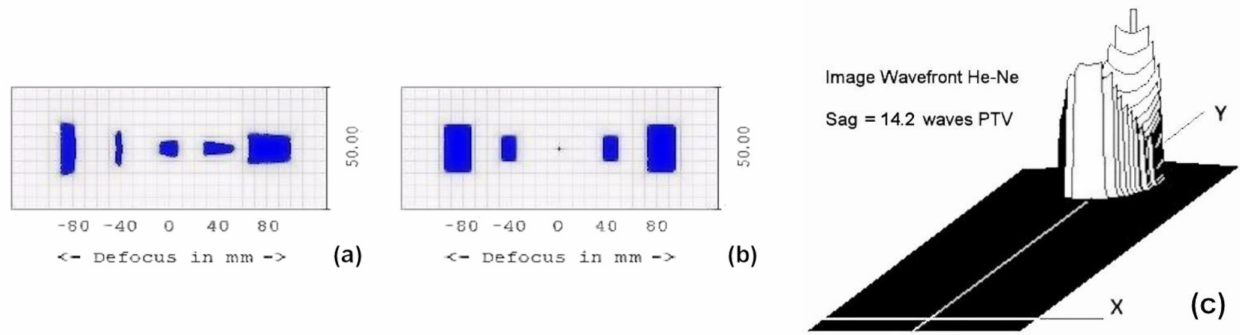
Figure 3. Images through focus before and after Sph -3 correction of the spectrograph telemeter 20 × 30-mm 2 area ( a ) before and ( b ) after correction. Wavefront shape from telemeter flat-segment at focus image shows Astm 3 aberration before apherization over a 30-mm diameter area—wavefront tilt removed ( c